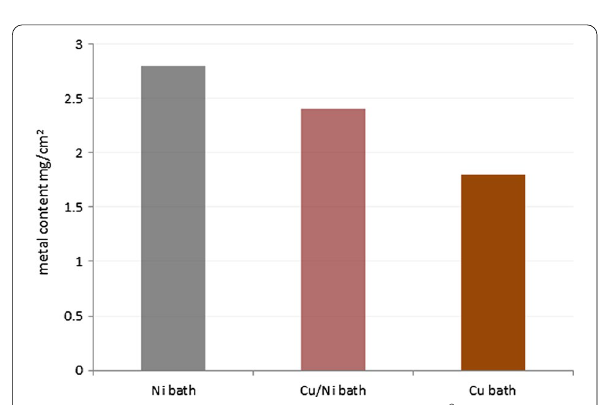
Fig. 5 Determination of Ni and Cu contents (mg/cm 2 ) of electrolytically colored Al samples at constant anodization time of 30 min